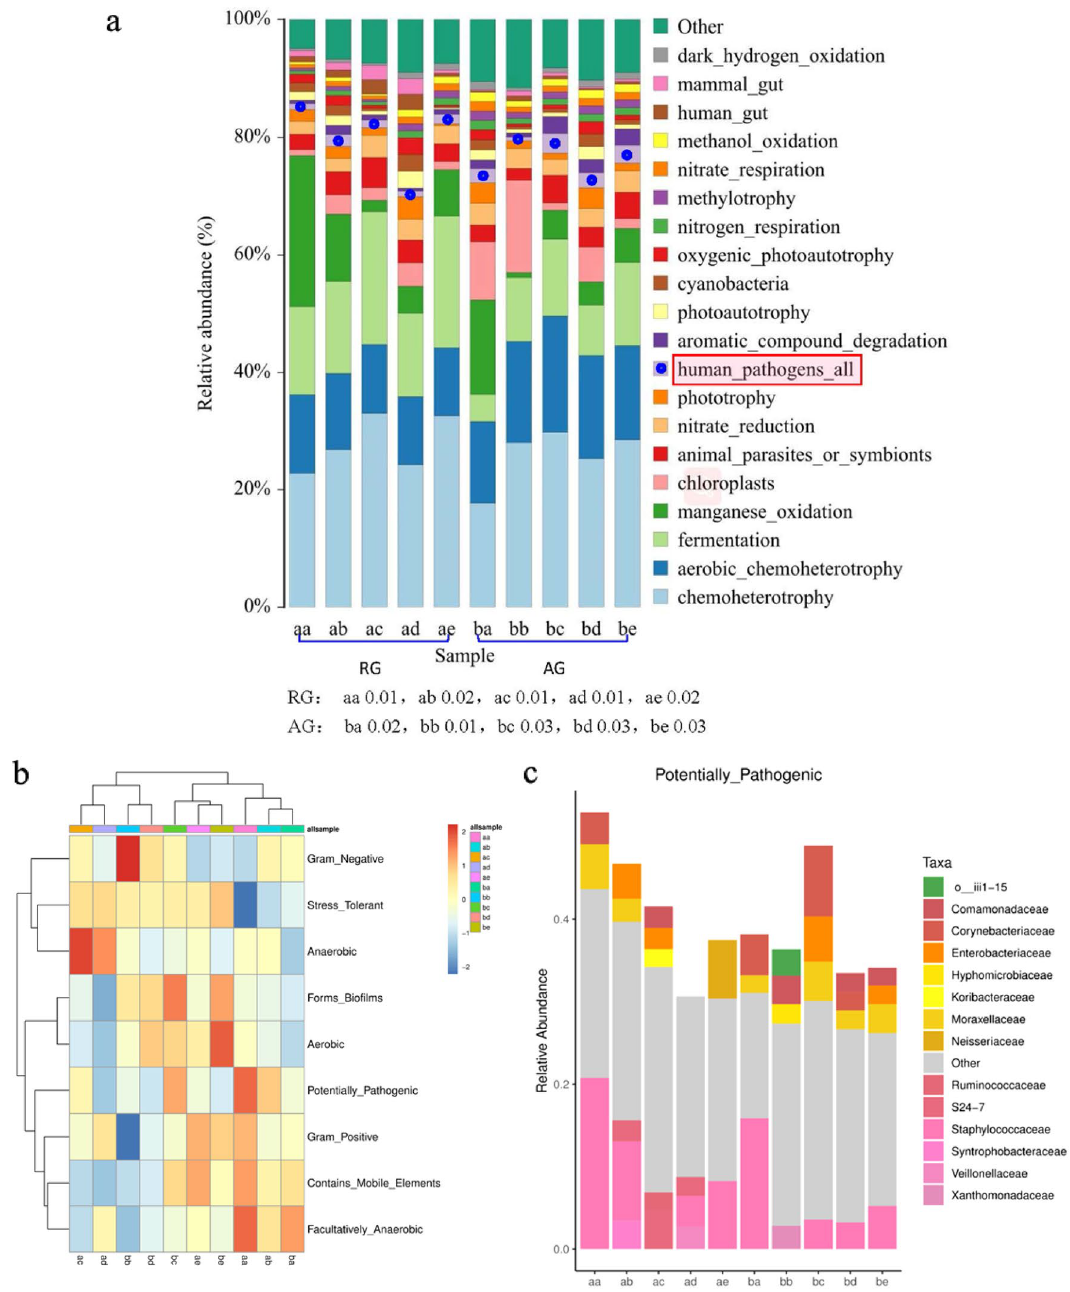
Figure 2. Bar chart of FaproTax function prediction of microbiome in two gyms, ( a ) (TOP 20 in functional abundance; P: 0.05). ( b ) Phenotypic functional maps of the microbiome of the two gyms predicted by BugBase algorithm; ( c ) opportunistic pathogens or dominant microbiota associated with cancer displayed at the family-